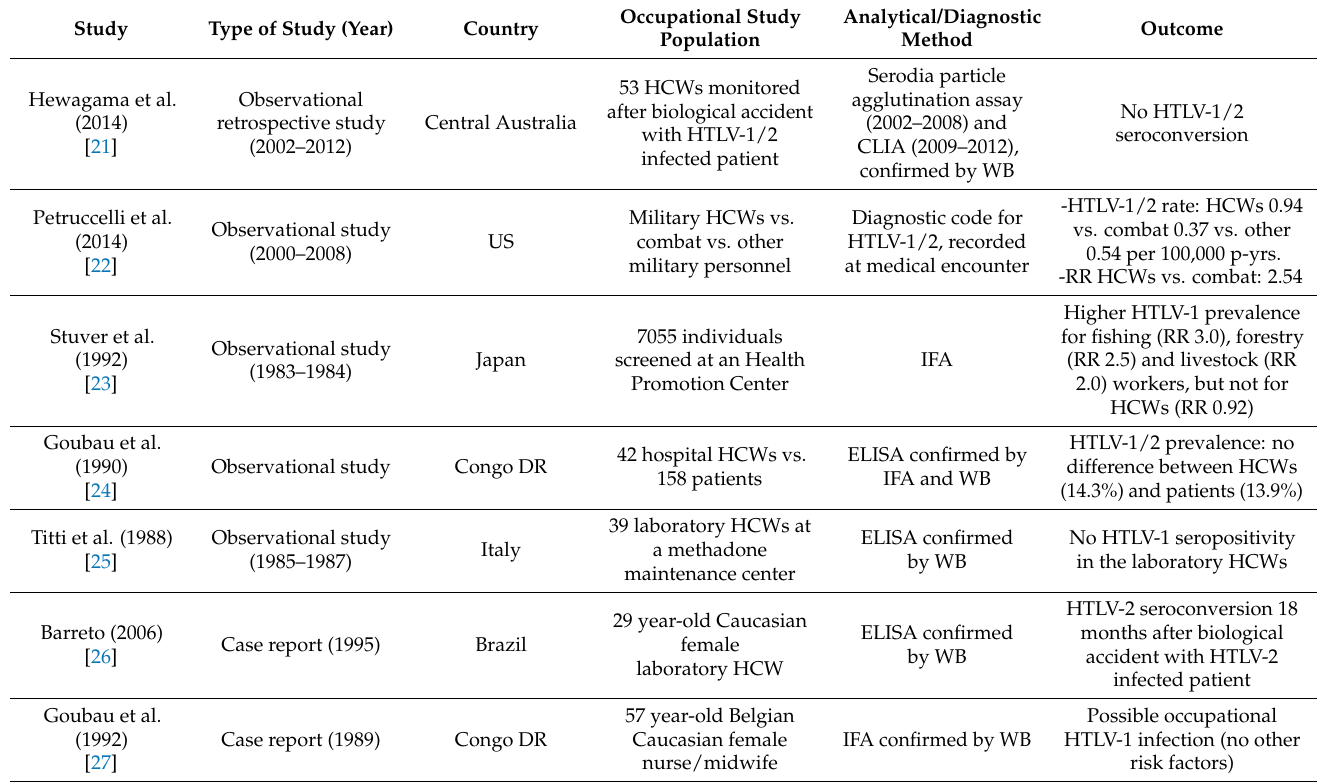
Table 1. Studies on work-related HTLV-1/2 infection in health care workers